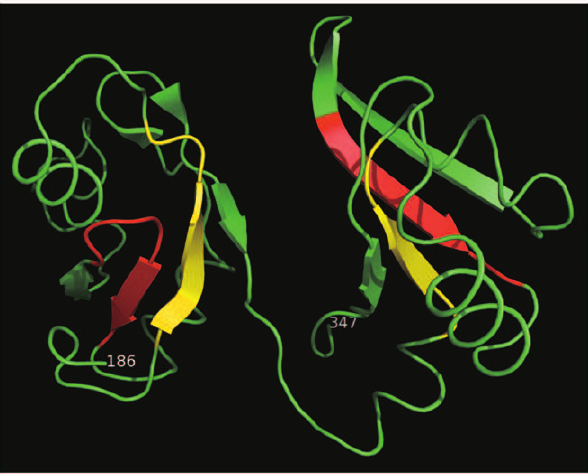
Figure 5. Ribbon model of the putative RNA-binding globular domain. The ribbon model was constructed by comparative homology approaches. The fold of the domain was identified by fold-prediction meta-server. Due to low pair-wise sequence identity of nearly 10% between the query and identified template, the derived atomic coordinates for the ERD4 globular domain were expected to be of low-resolution. The two ribonucleoprotein motifs (RNP1 and RNP2) in each of the RNA-recognition domains are shown in red and yellow, respectively. The figure was prepared by PyMol (http://www.pymol.